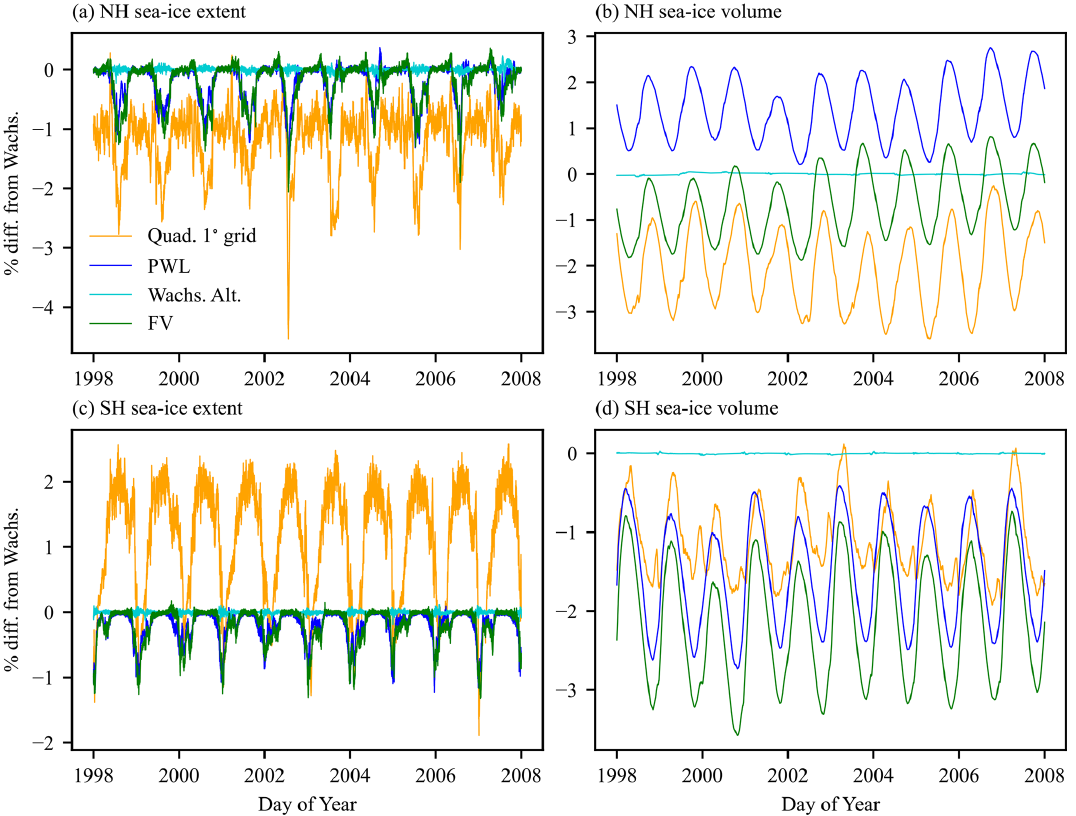
Figure 21. Difference (%) in hemispheric sea-ice extent (a, c) and volume (b, d) between global simulations using the Wachspress variational scheme with a quasi-uniform 30km SCVT mesh and several other simulations. Results are shown for the Northern Hemisphere (a, b) and Southern Hemisphere (b, d) .